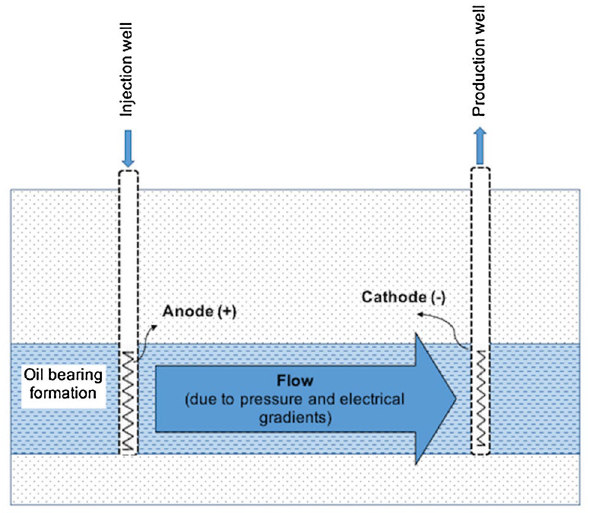
Fig. 1 Schematic showing field operation of combined EEOR and water